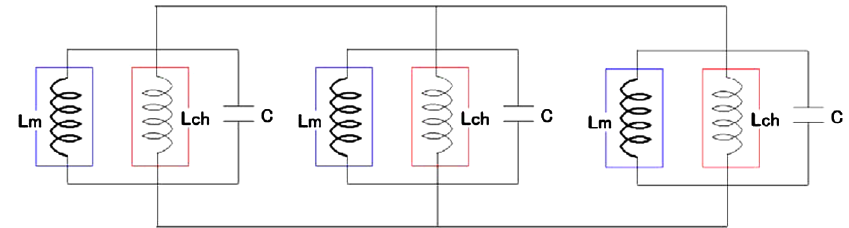
FIG. 15. Equivalent circuit for the resonant